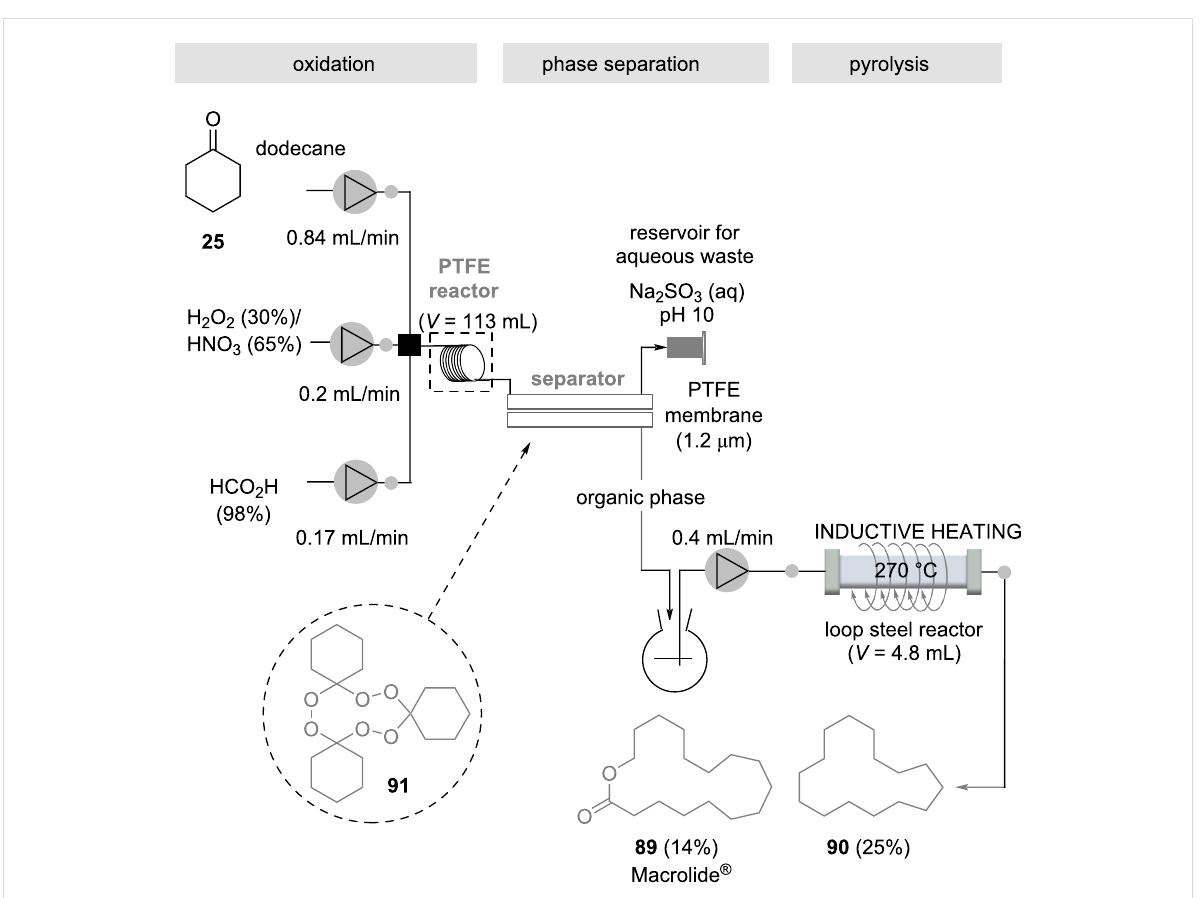
Scheme 17: Three-step continuous flow synthesis of macrocycles 89 and 90 with musk-like olfactoric